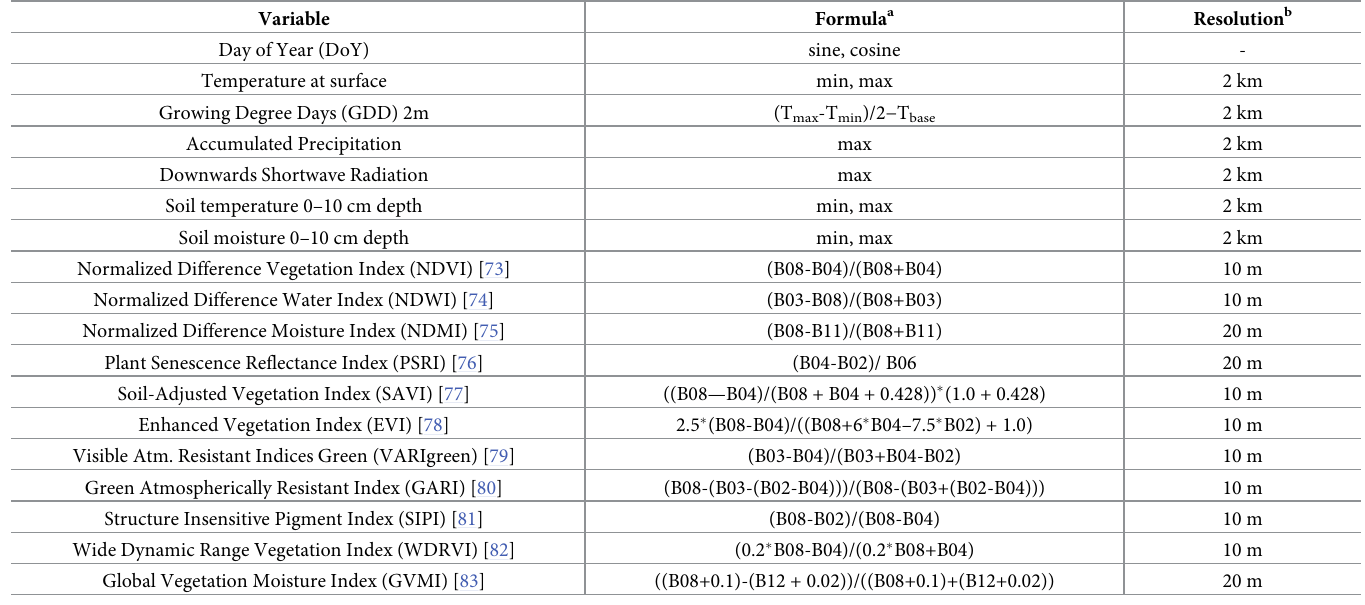
Table 4. Summary of predictor variable